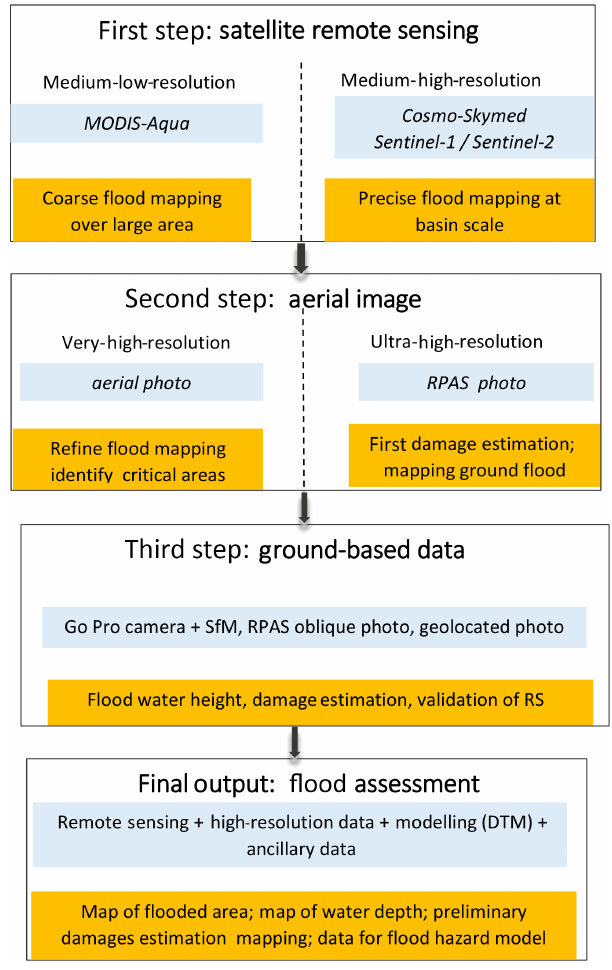
Figure 2. Flowchart illustrating the multiscale flood mapping ap- proaches proposed in this